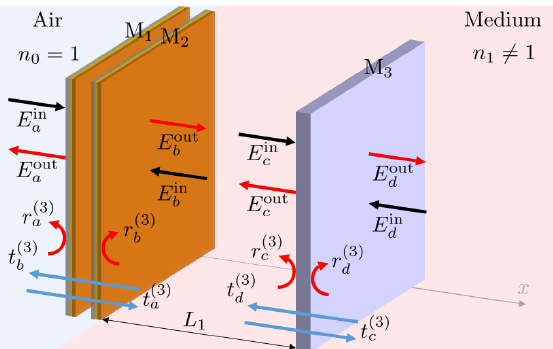
Figure 7. Schematic view of a three-mirror system, which contains two mirrors M 1 and M 2 , separated by a distance of L 0 and a third mirror, M 3 , a distance of L 1 away from the M 1 - M 2 cavity. In a realistic scenario, the setup might be attached to a dielectric medium with a refractive index n (cid:54) = 1. The figure also shows the relevant electric field amplitudes E in mirror interfaces. However, notice that these reflect the case where the medium is replaced by air, as described in Section